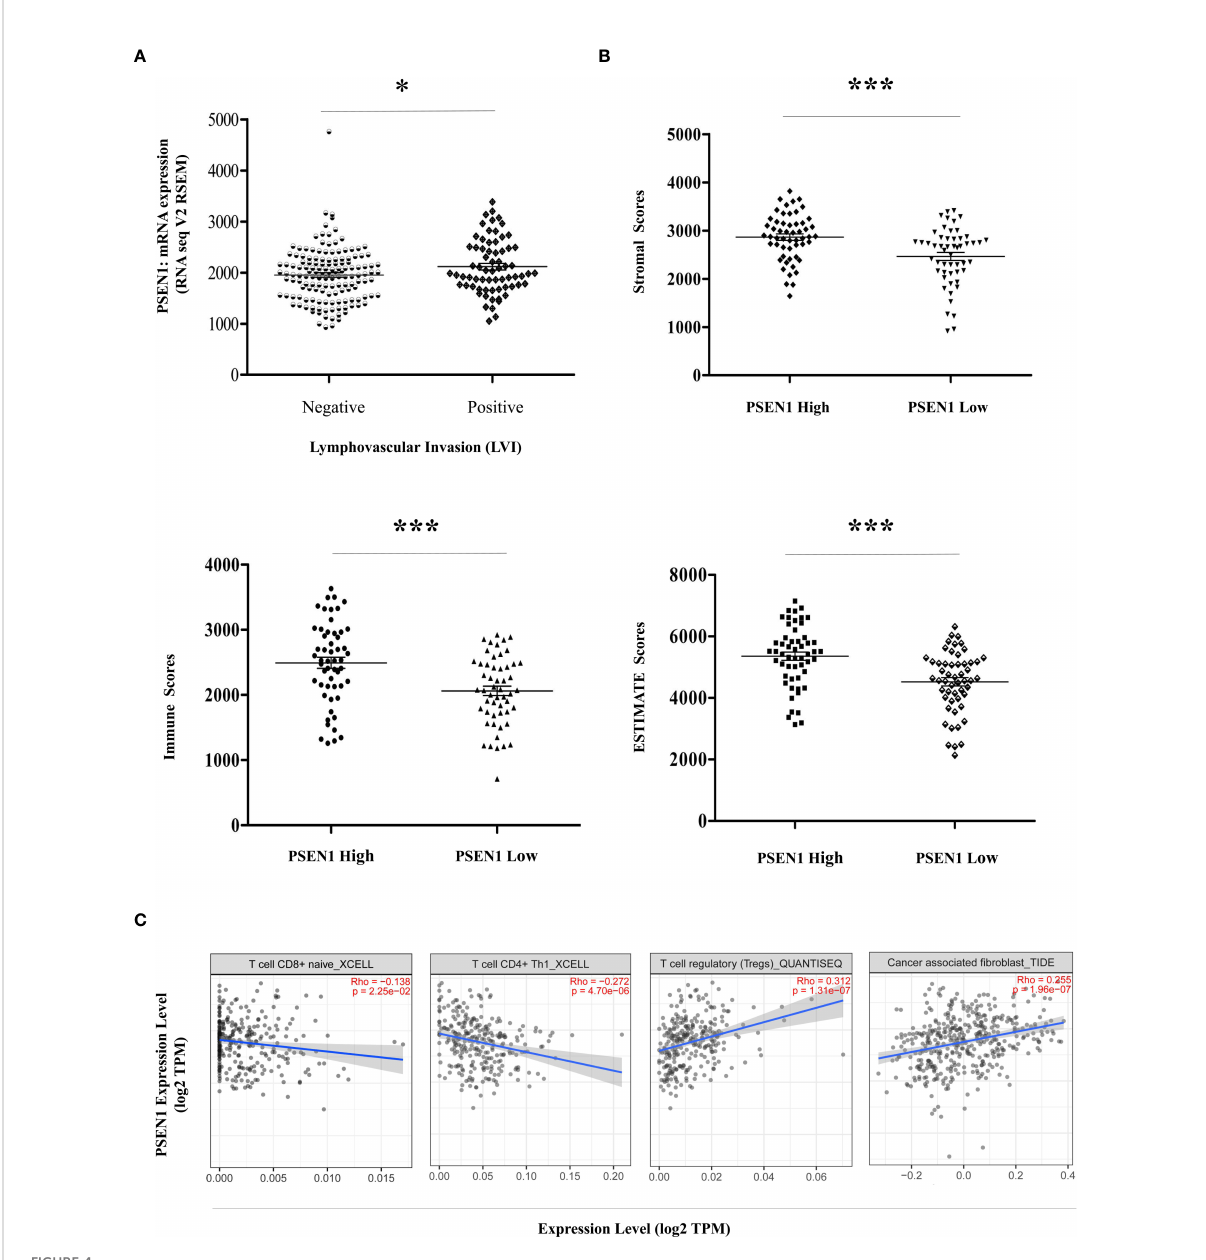
FIGURE 4 PSEN1 impacts invasiveness and immunophenotypes in Colon Cancer. (A) Levels of PSEN1 mRNA expression compared between the COAD cases in the presence (n=68) or absence (n=145) of lymphovascular invasion. The read counts were quanti fi ed in RSEM. (B) The stromal scores (upper), immune scores (lower left) and combined ESTIMATE scores (lower right) compared between the dichotomized COAD cases based on PSEN1 mRNA expression. The signi fi cance was indicated with the symbols (*P<0.05 ***P<0.001). (C) Correlations of PSEN1 with the in fi ltration abundance of naïve CD8 + T cells, CD4 + Th1 cells, Tregs and cancer associated fi broblasts (CAFs) explored by TIMER2.0. The purity-adjusted spearman ’ s rho and signi fi cance were